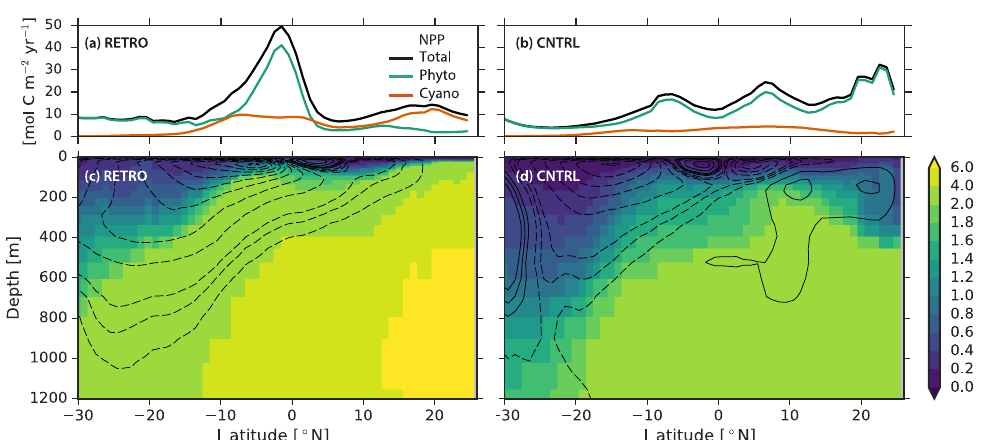
Figure 17. Zonal means in the Indian Ocean for RETRO (a, c) and CNTRL (b, d) : net primary production (NPP, a , b , black, molCm − 2 yr − 1 ) with contributions of bulk phytoplankton (green) and cyanobacteria (red); phosphate concentration ( c , d ) (mmolm − 3 ). Contours of MOC are overlaid at levels of ± 1, 2, and multiples of